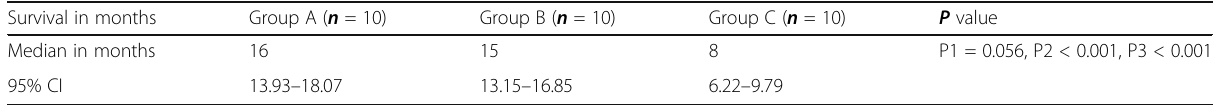
Table 4 Overall survival at end of our study Survival in